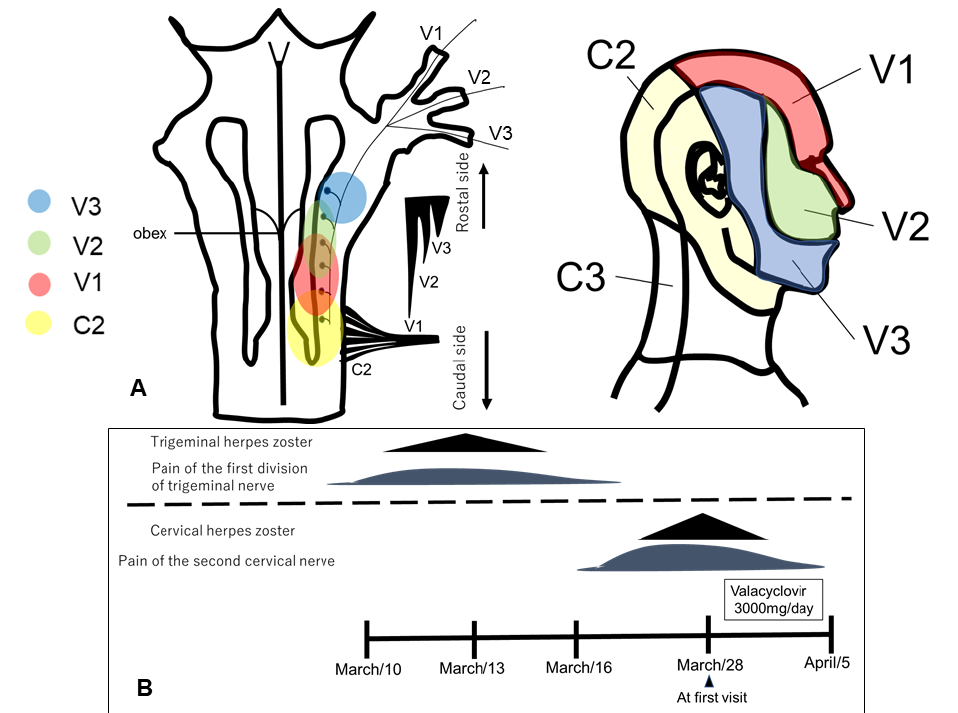
Figure 2. ( A ): Organization of trigeminal spinal nucleus caudalis and upper cervical spinal cord from peripheral region. V1–3: trigeminal regions 1–3. C2,3: cervical spinal cord. ( B ): Clinical course from 10 March to 5 April.